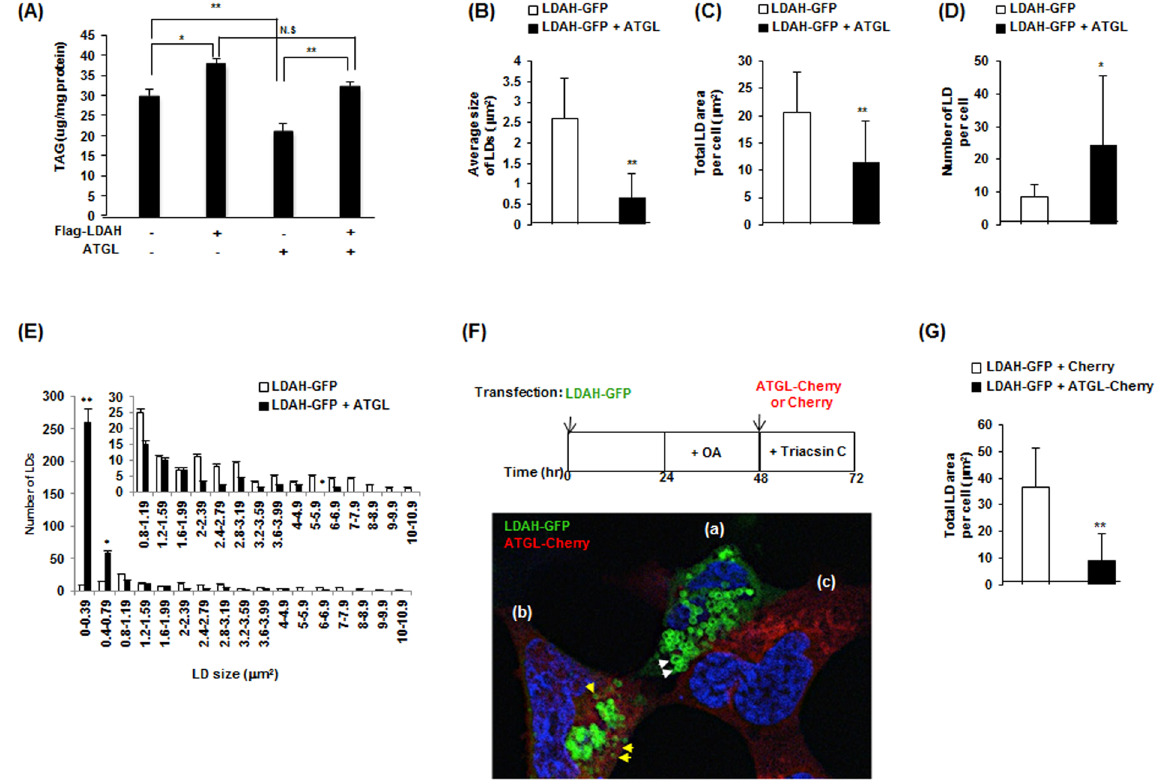
** p < 0.005. ( F ) Diagram of experimental approach (top). LDAH-GFP transfected cells were treated with OA (360 μ M) for 24 h. Cells were then transfected with ATGL-cherry in the presence of triacsin C (1 μ g/ml). Expression of LDAH-GFP alone (a) and ATGL-cherry alone (c), and co-expression of LDAH-GFP and ATGL- cherry (c) were visualized by confocal microscopy. White arrows: LDs in cells expressing only LDAH-GFP. Yellow arrows: LDs in cells expressing both LDAH-GFP and ATGL-cherry. ( G ) Quantification of LD area per cell in cells overexpressing both LDAH-GFP and Cherry, or both LDAH-GFP and ATGL-Cherry (n = 14 per group). ** p <